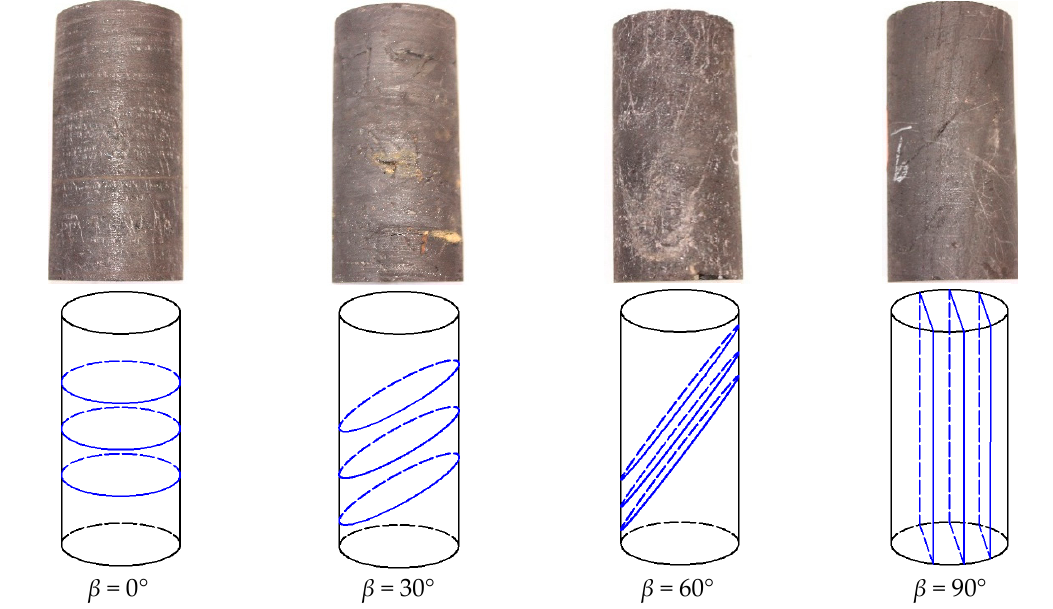
Figure 1. Coal samples and corresponding bedding angles.